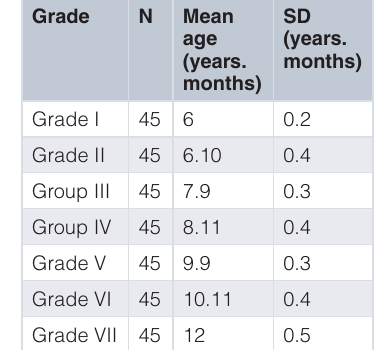
Table 1. Demographic details of the participants.